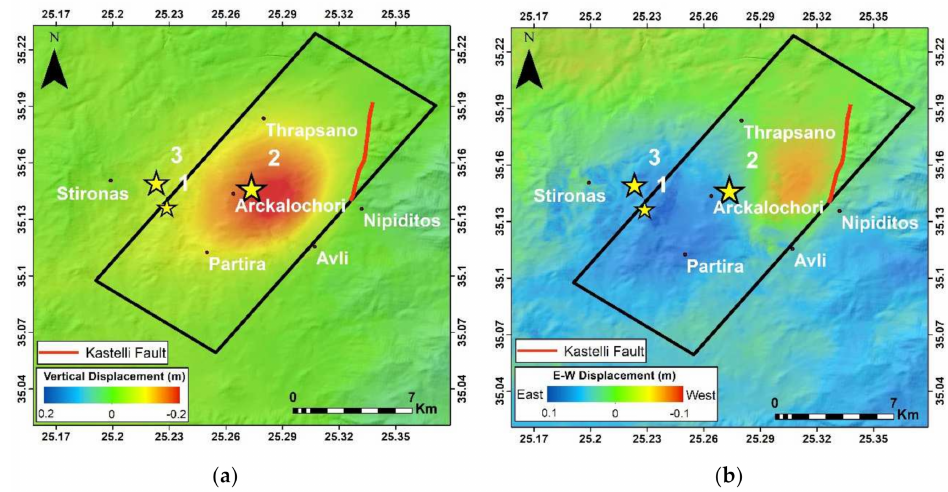
Figure 6. Vertical displacements ( a ) and E-W ( b ) direction for the 27 September 2021 earthquake. Symbol key as in Figure 5.